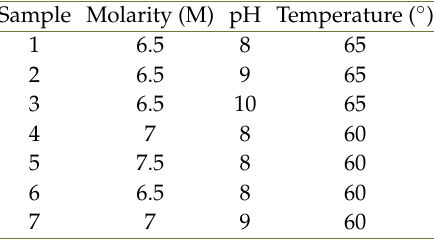
Table 1. Synthesis parameters of Ni-PSAC